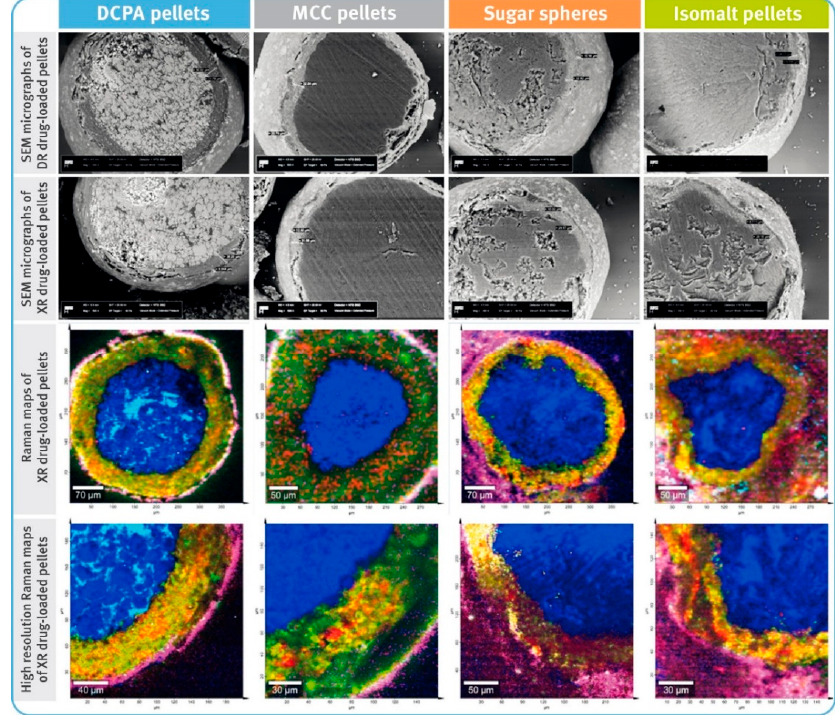
Figure 2. SEM micrographs of cross-sections of diclofenac sodium DR and XR pellets (magnification of 500×) and Raman maps of XR pellets (spatial resolution of 10 µm and high resolution of 3 µm); location of diclofenac sodium marked with red color, core material with different shades of blue, hypromellose—green to yellow, and polymethacrylate-based coating—pink. Pharmaceutics 2021 , 13 , x